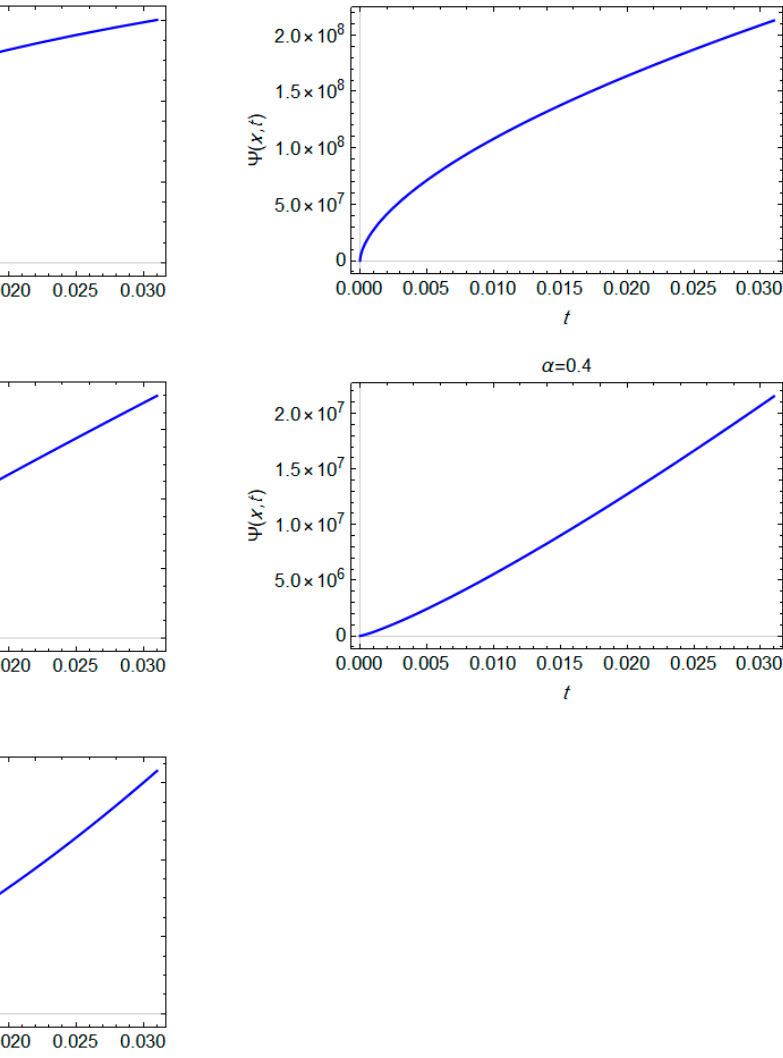
Figure 1. Two-dimensional graphs of neutron flux ψ ( x , t ) for α = 0.1, 0.2, 0.3, 0.4, and 0.5 (colored online).